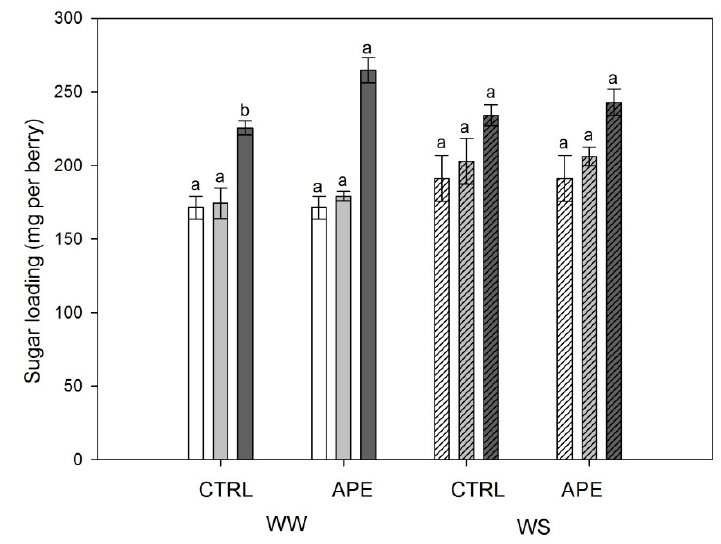
Figure 2. Sugar loading of V. vinifera treated with A. platensis F&M-C256 extract (APE) and control plants (CTRL), under two water regimes (well-watered, WW; water-stressed, WS). Assessments were attended at t 0 (white columns), t 1 (light grey columns), and t 2 (dark grey columns). One-way ANOVA was performed on data (mean ± SE, n = 10). Within the same water regime and stage, di ff erent letters mean significant di ff erences among APE and CTRL (LSD test, p ≤ 0.05). Both in WW and in WS irrigation regimes, at t 0 (before A. platensis F&M-C256 treatments) and t 1